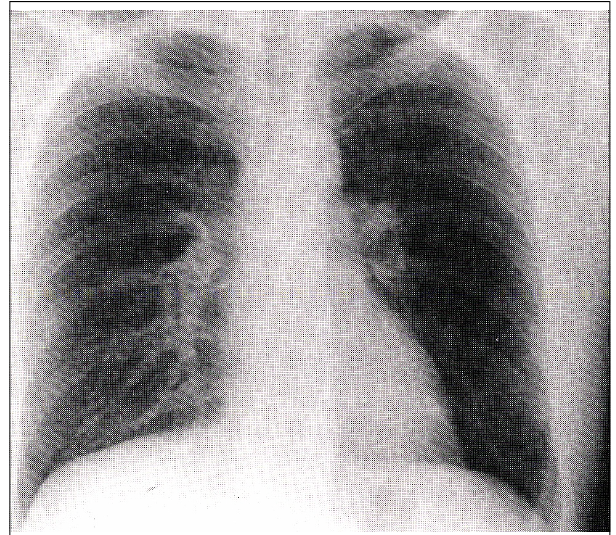
Fig ure 3) An tero pos te rior chest ra dio graph of case 2. Note the dif fuse in crease in in ter sti tial mark